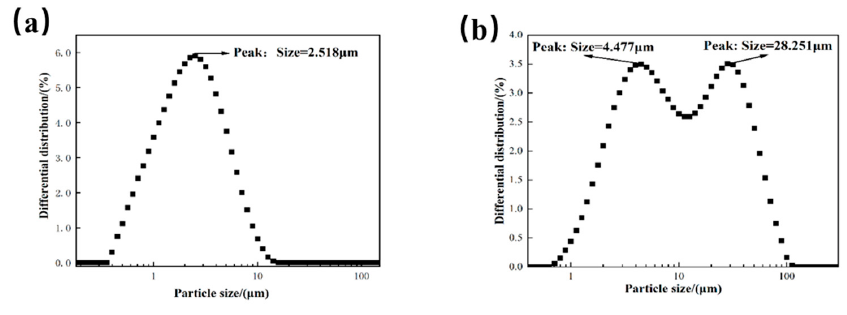
Figure 7. ( a ) Cleaning slurry particle size, ( b ) particle size of cleaning slurry and sludge mixture.